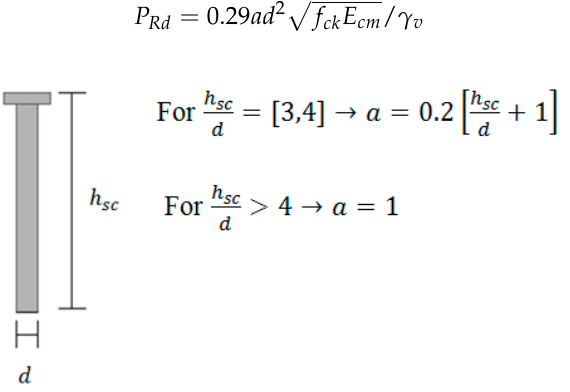
Figure 6. Calculation of the parameter a .